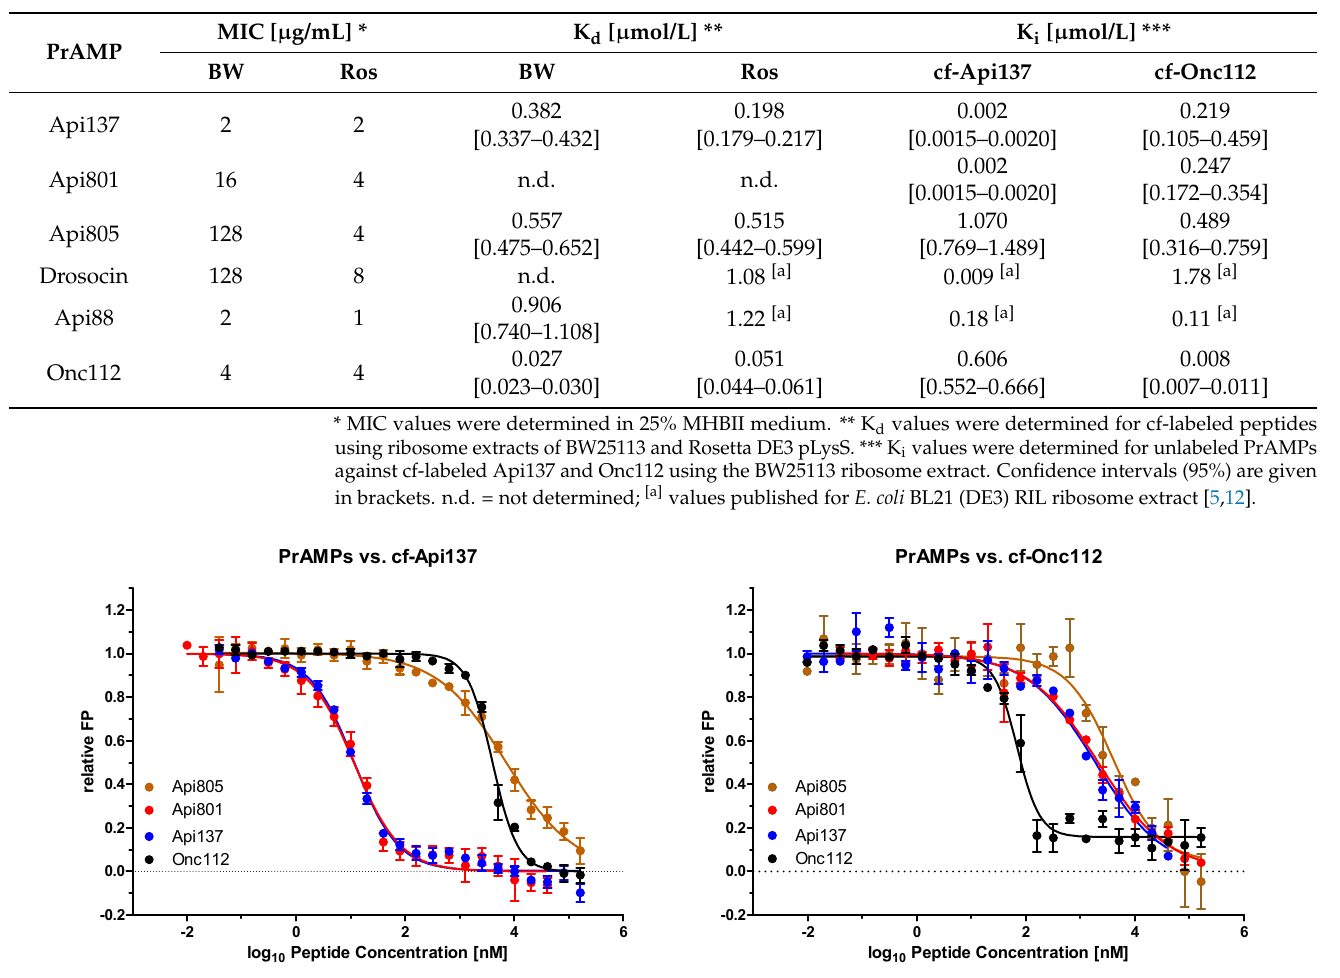
Table 2. Antibacterial activities, dissociation (K d ), and inhibition constants (K i ) of ribosome binding obtained for all PrAMPs included in the current study for E. coli strains BW25113 (BW) and Rosetta DE3 pLysS (Ros).